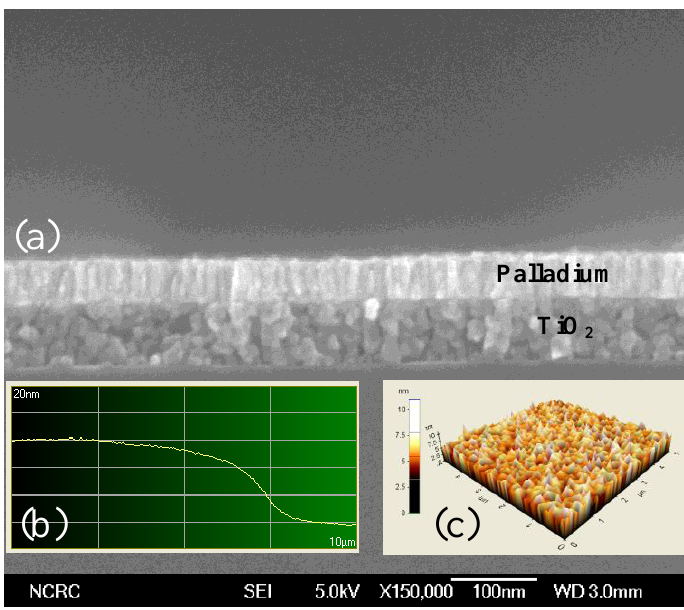
Figure 3. Surface & device thickness analysis: (a) FE-SEM image, (b) AFM, (c) morphology from AFM.